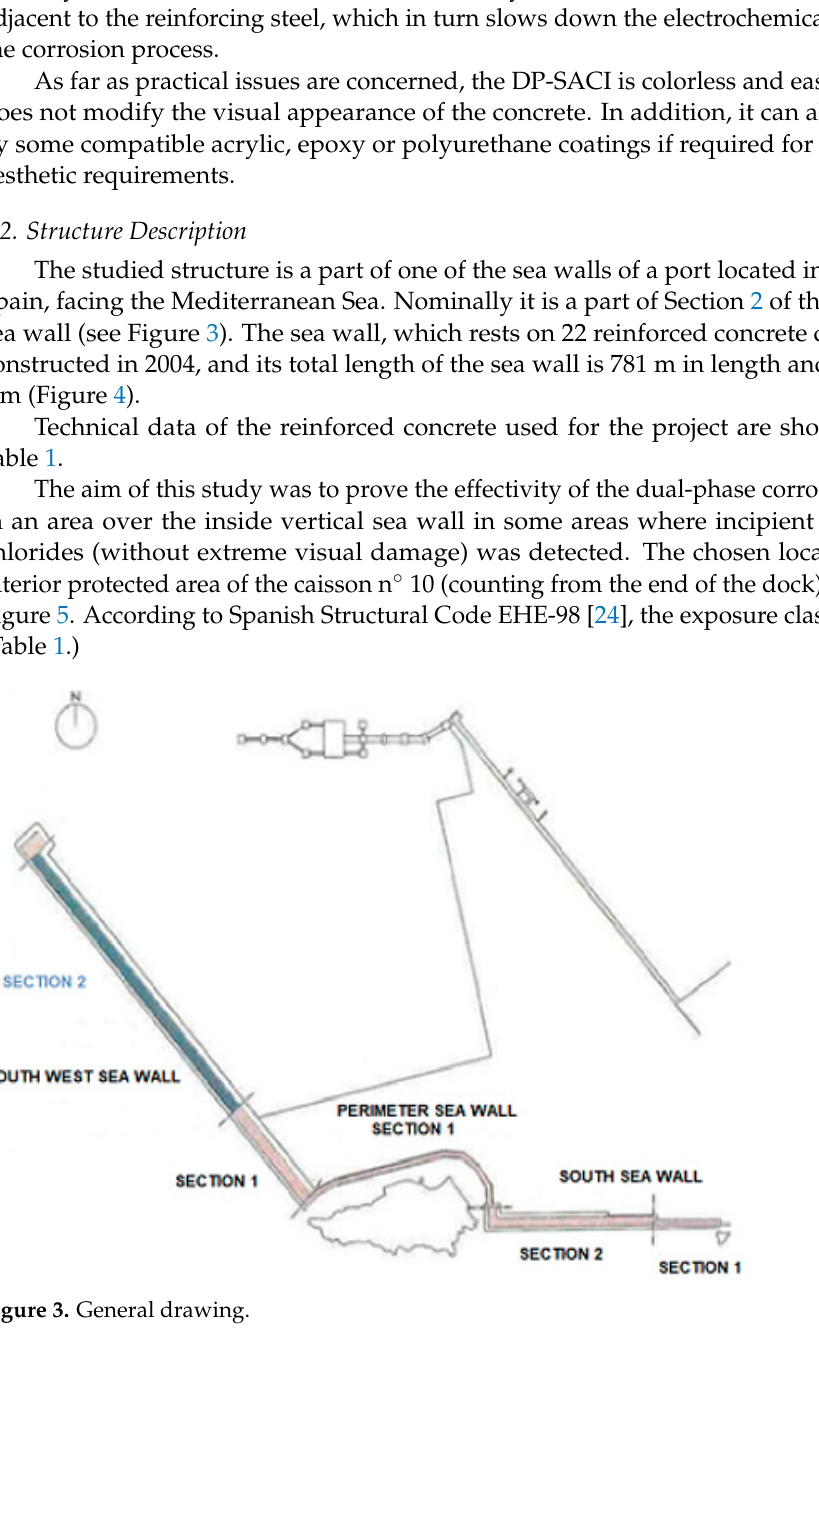
Figure 4. Elevation and section detail/drawing of the South West sea wall. Technical data of the reinforced concrete used for the project are shown below in Ta- ble 1. Table 1. Concrete description and Service Life Design. Concrete Description HA-30/20/IIIa + Qb Concrete cover